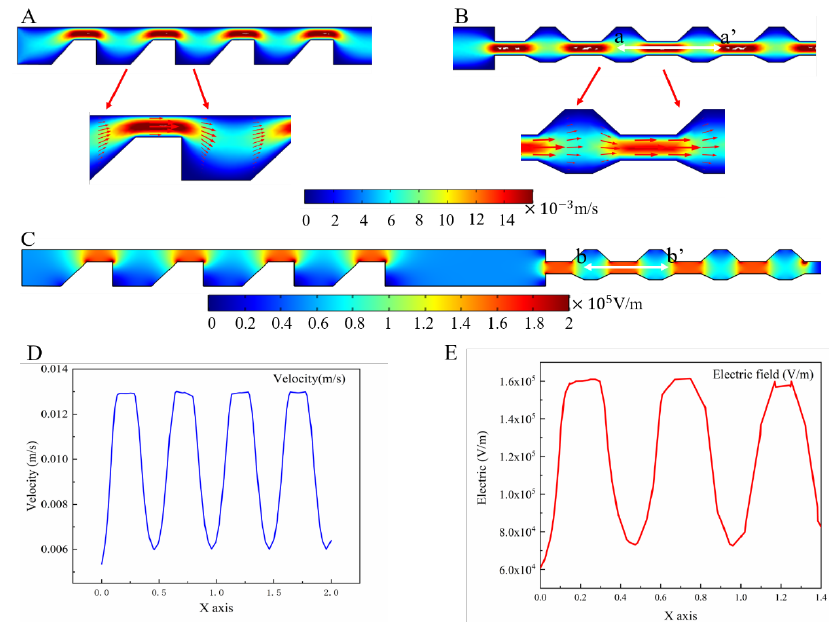
Figure 3. ( A ) Distributions of the flow field in contraction and expansion of the entrance part; ( B ) distributions of the flow field in contraction and expansion of the outlet part; ( C ) distribution of the electric field; ( D ) a – a ’ cross-section of the central part of the CEA channel; ( E ) electric field distribu- tion of b –b’ cross -section. The trajectory of the particles was affected except by the dielectrophoretic force and particle size. It also depended on the Clausius – Mossotti (CM) factor value, which varied with the conductivity and dielectric properties of the particles and dielectric solution, as well as the frequency of the applied electric field. The CM factor value was calculated and simulated using the Matrix Laboratory (MATLAB) program to obtain three kinds of par- ticle at different frequencies and solution conductivities, as shown in Figure 4A – C. Figure 4A shows that when the solution conductivity was 4 µS/cm, the CM factor was zero and the 4 µm polystyrene spheres were not affected by the dielectrophoretic force; when the solution conductivity was higher than 4 µS/cm, no matter how the applied frequency changed, the dielectrophoretic force was negative. If the solution conductivity was smaller than 4 µS/cm, the particles within 100 kHz were subjected to positive dielectrophoretic force, and vice versa, by negative dielectrophoretic force. Figure 4B illustrates the varia- tion with the direction and magnitude of the dielectrophoretic force on the 4 µm silica spheres when the conductivity of the solution or the frequency of the electric field changed. Due to the low conductivity of silica, no matter how the conductivity of the so- lution varied, the particles were subjected to negative DEP force in the nonuniform electric field. Figure4C shows the CM factor of the 20 µm polystyrene spheres with the change in solution conductivity and frequency. It was observed that the particles within 20 kHz were subjected to positive dielectrophoretic forces only at a conductivity of 0.1 µs/cm.